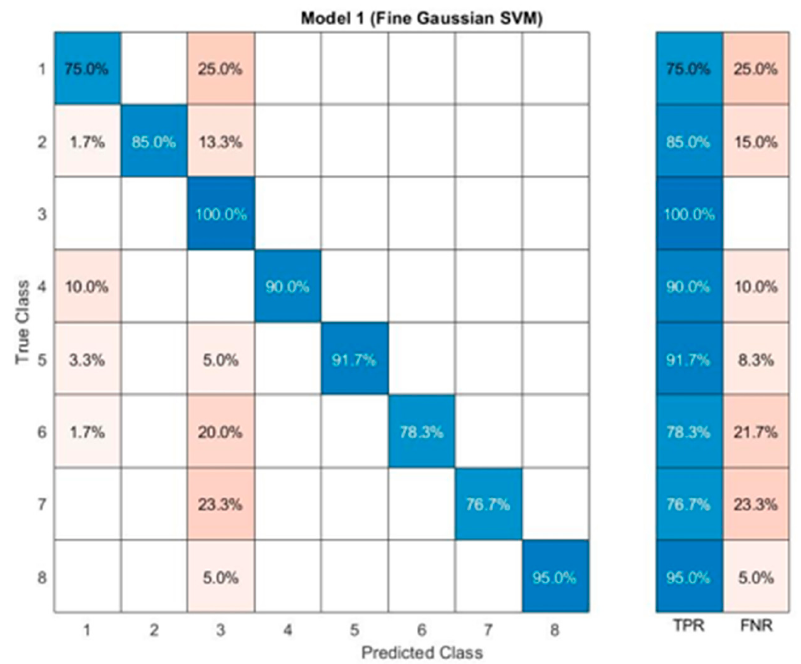
Figure 8. Fine Gaussian SVM model confusion matrices.